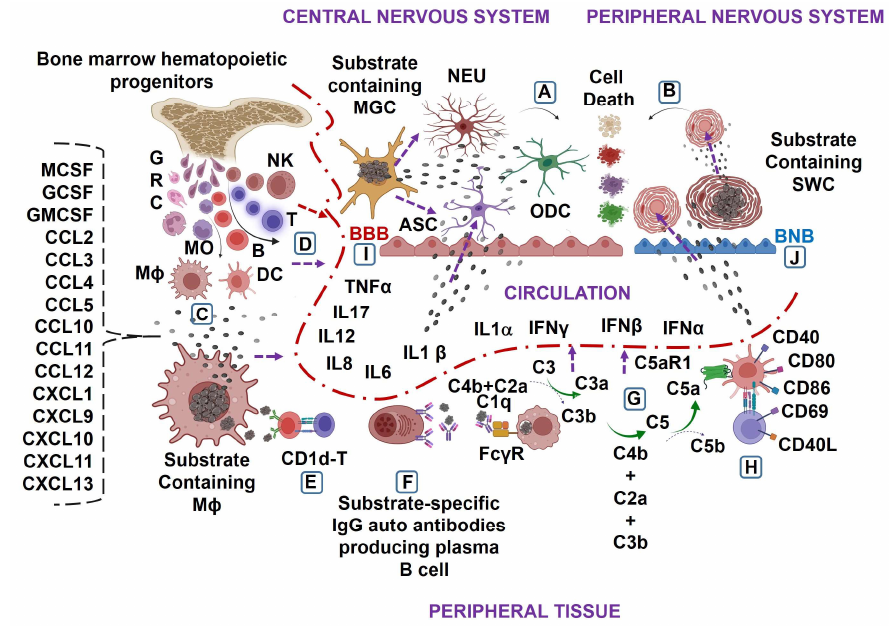
Figure 1. Model of neuroimmune inflammation induced by genetic defects and excess substrate accumulation in lysosomal storage diseases. Genetic defects can lead to the excessive accumulation of substrates associated with lysosomal storage diseases. In the central nervous system, microglial cells (MGCs) and, in the peripheral nervous system, Schwann cells (SWCs) are particularly affected. This accumulation of substrates can cause the local production of pro-inflammatory cytokines, including interferon alfa (IFN α ), interferon beta (IFN β ), interferon gamma (IFN γ ), tumor necrosis factor alfa (TNF α ), interleukin (IL)1 α , IL1 β , and IL6, resulting in the death of neurons (NEU), astrocytes (ASC), oligodendrocytes (ODC), and SWCs in lysosomal storage diseases ( A , B ). Similarly, the excess accumulation and continuous release of substrates from macrophages (Mϕ) in peripheral tissues can cause the massive generation of growth factors, such as Mϕ-colony-stimulating factor (MCSF), granulocyte-colony-stimulating factor (GCSF), and granulocyte-Mϕ colony-stimulating factor (GMCSF), C-C motif ligand chemokines (e.g., CCL2, CCL3, CCL4, CCL5, CCL10, CCL11, and CCL12), and C-X-C motif ligand